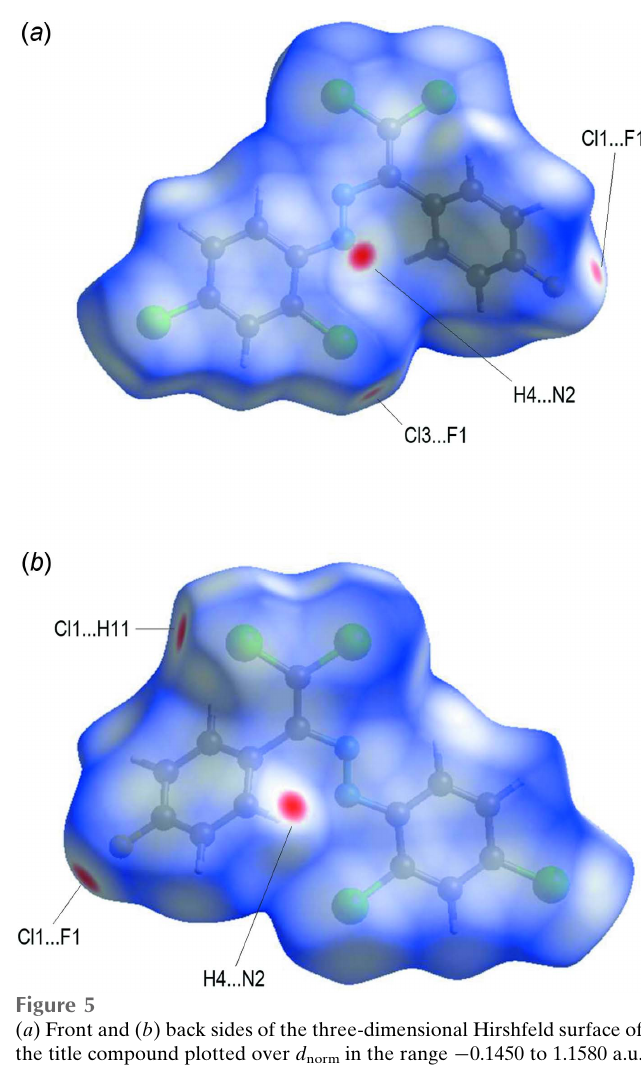
Figure 5 ( a ) Front and ( b ) back sides of the three-dimensional Hirshfeld surface of the title compound plotted over d norm in the range (cid:4) 0.1450 to 1.1580 a.u.